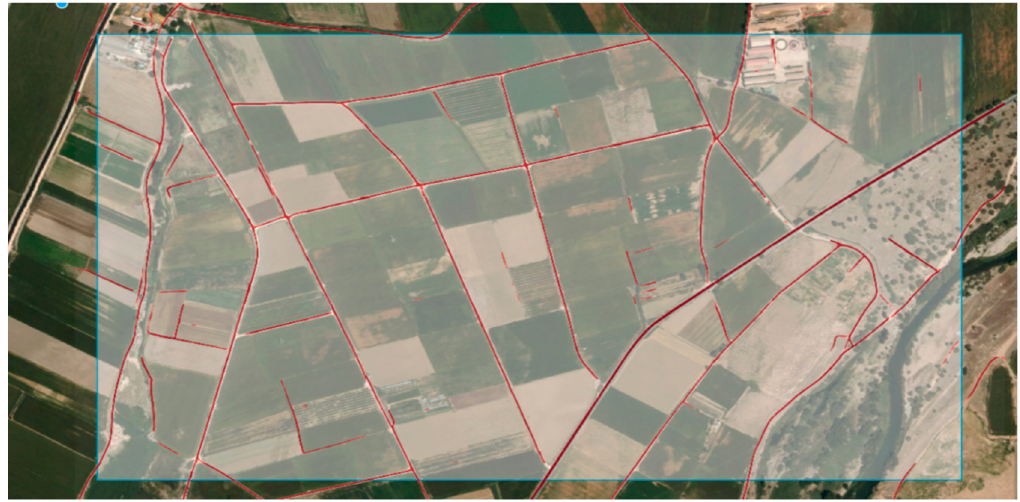
Figure 9. Per-pixel predictions of the best performing hybrid segmentation model covering an area of 5.24 km 2 (160 tiles). In the map scheme’s representation, bright red means a higher probability of the pixel belonging a road while transparent is used for pixels labelled with “No road”.